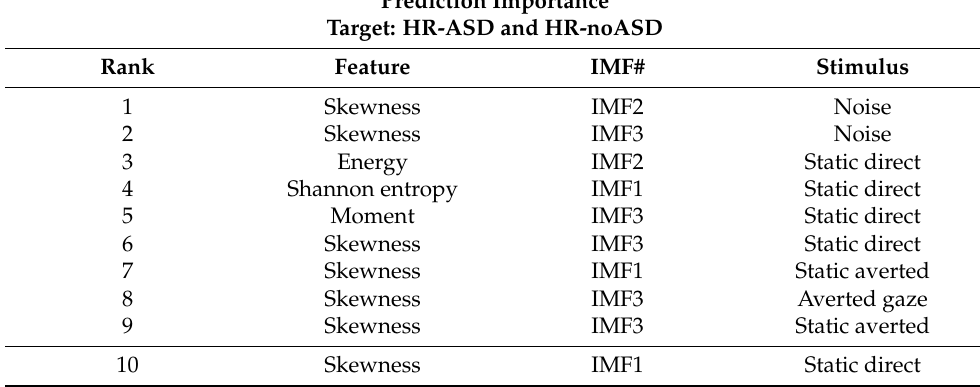
Table 6. Predictor importance for the k -NN classifier predicting diagnostic outcome from six features and six averaged